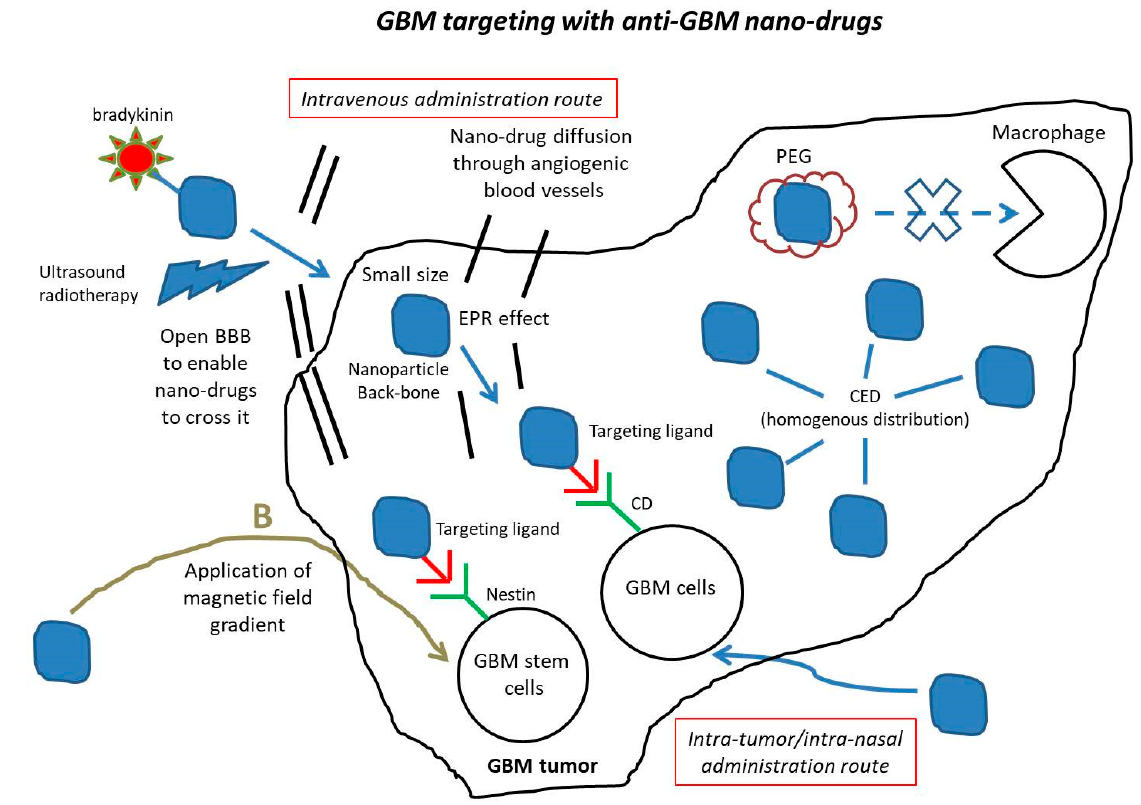
Figure 2. A schematic figure showing the various mechanisms by which anti-GBM nano-drugs can target the GBM tumor.